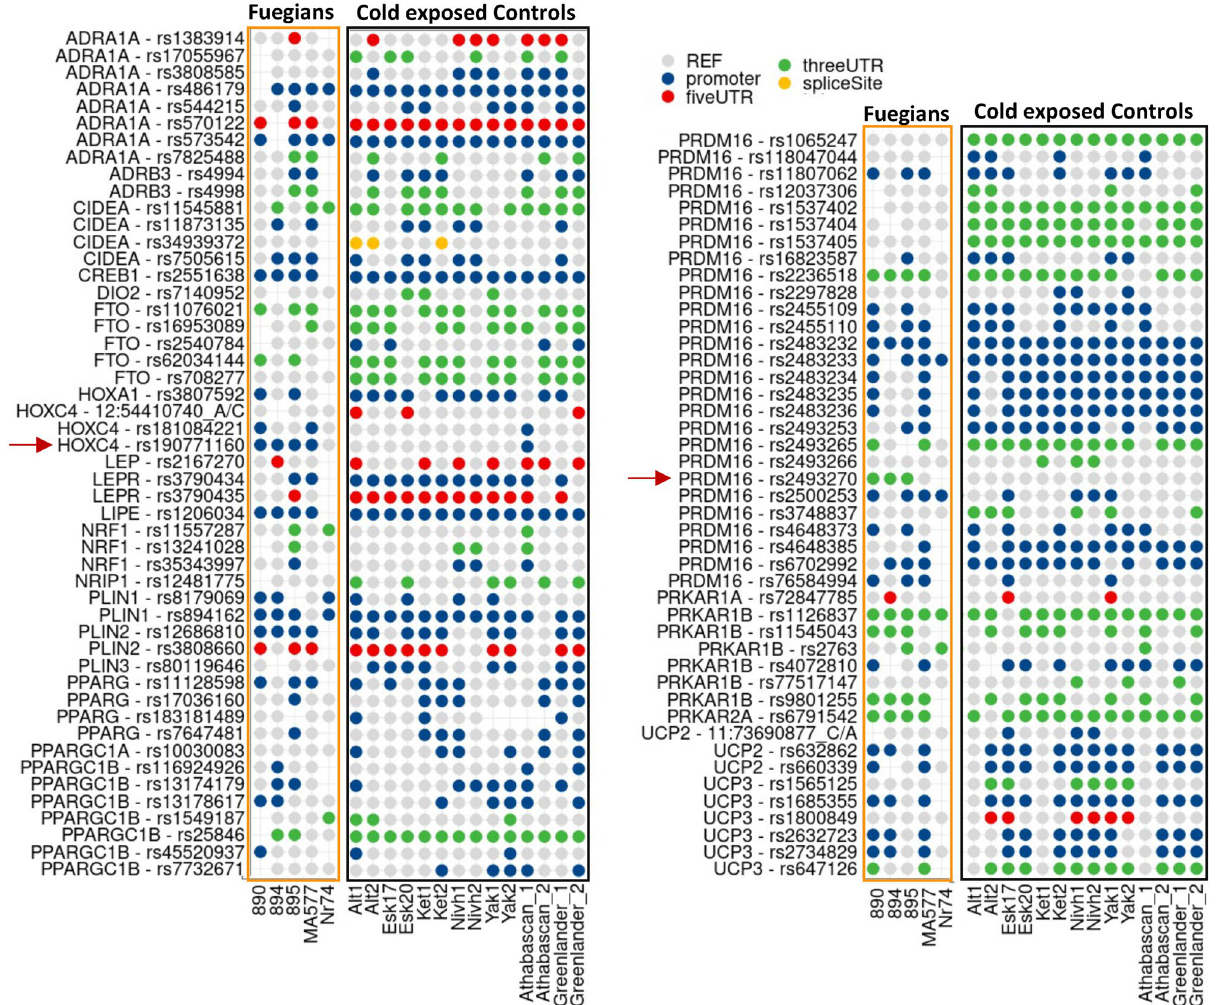
Figure 2. Non-coding variants of a panel of 28 genes involved in BAT functional pathways identified in at least 2 Fuegian genomes. All variants found in the Fuegians (890, 894, 895, MA577, Nr74) were searched in control population of 14 individuals including 10 Siberians (Alt1, Alt2, Esk17, Esk20, Ket1, Ket 2, Yak1, Yak2), 2 Athabascan (Athabascan_1, Athabascan_2) and 2 Greenlanders (Greenlander_1, Greenlander_2). Red arrows: variants of interest described within the